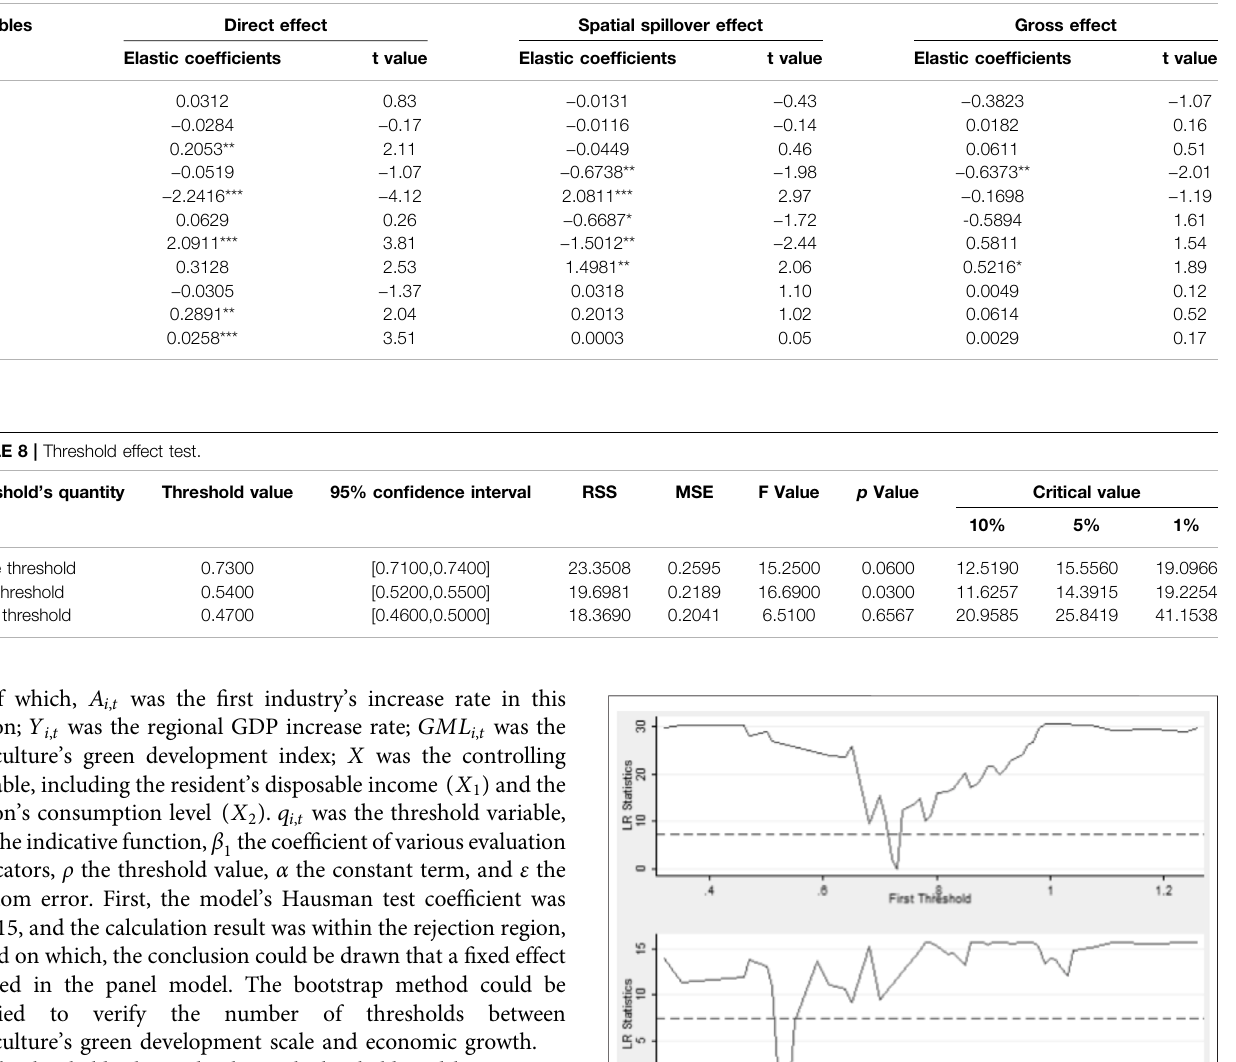
TABLE 7 | Spatial effect of Chinese agricultural green development.